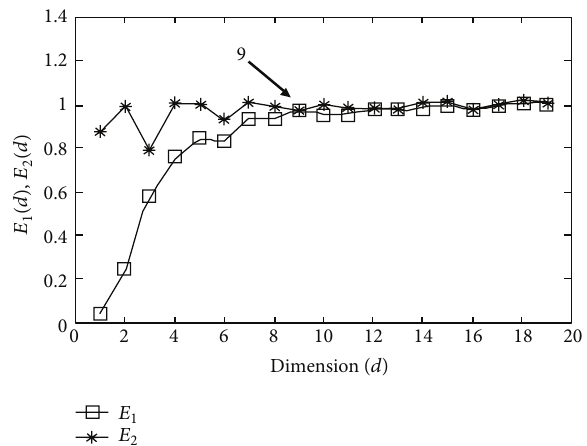
Figure 10: Selection of the embedding dimension by the CAO method of LTSA1.